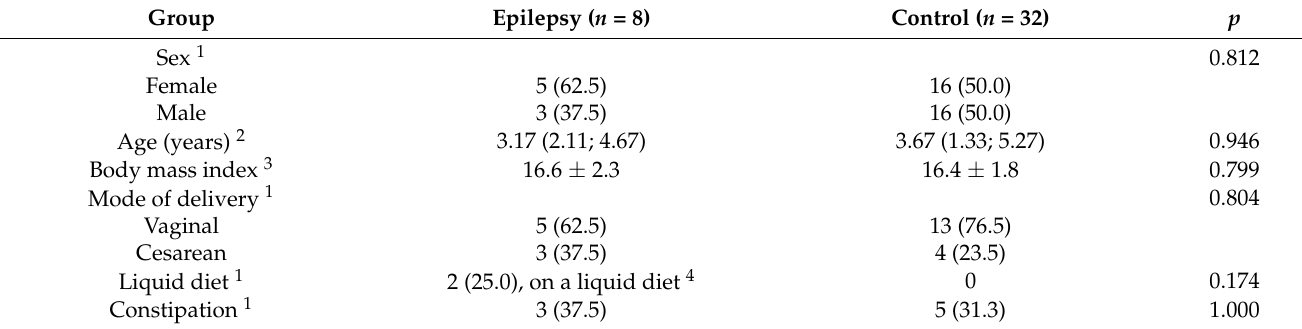
Table 3. Comparison between the clinical data of the epilepsy and control